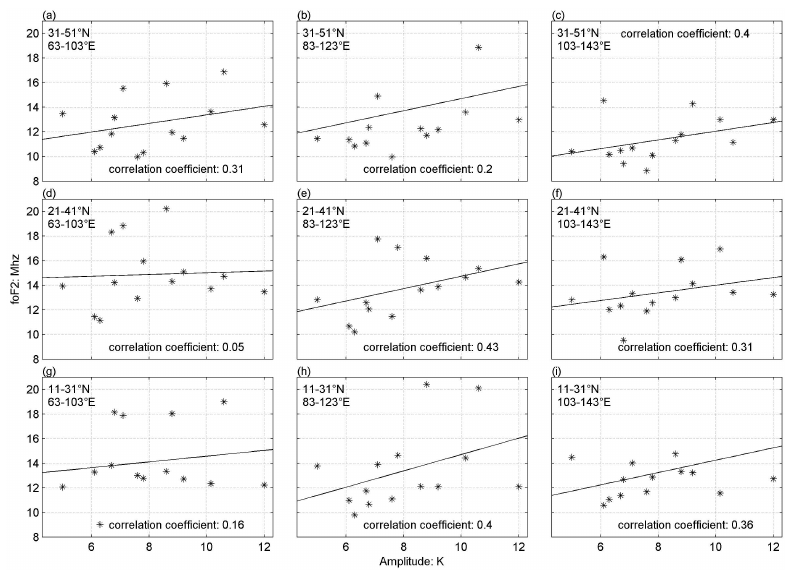
Fig. 13. The same as for Fig. 11 but for the Wenchuan